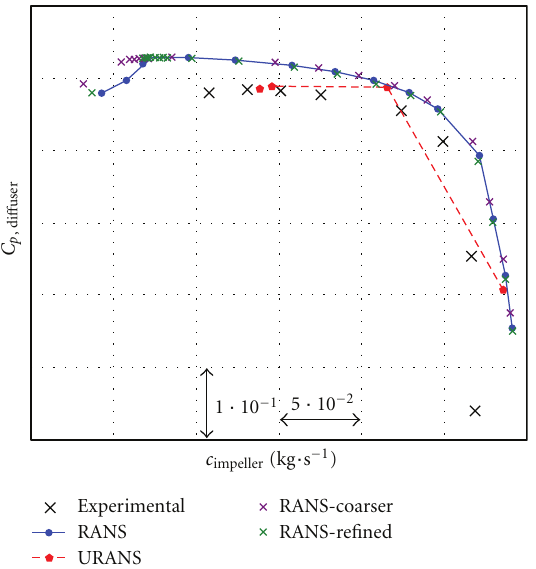
Figure 4: Di ff user static pressure recovery coe ffi